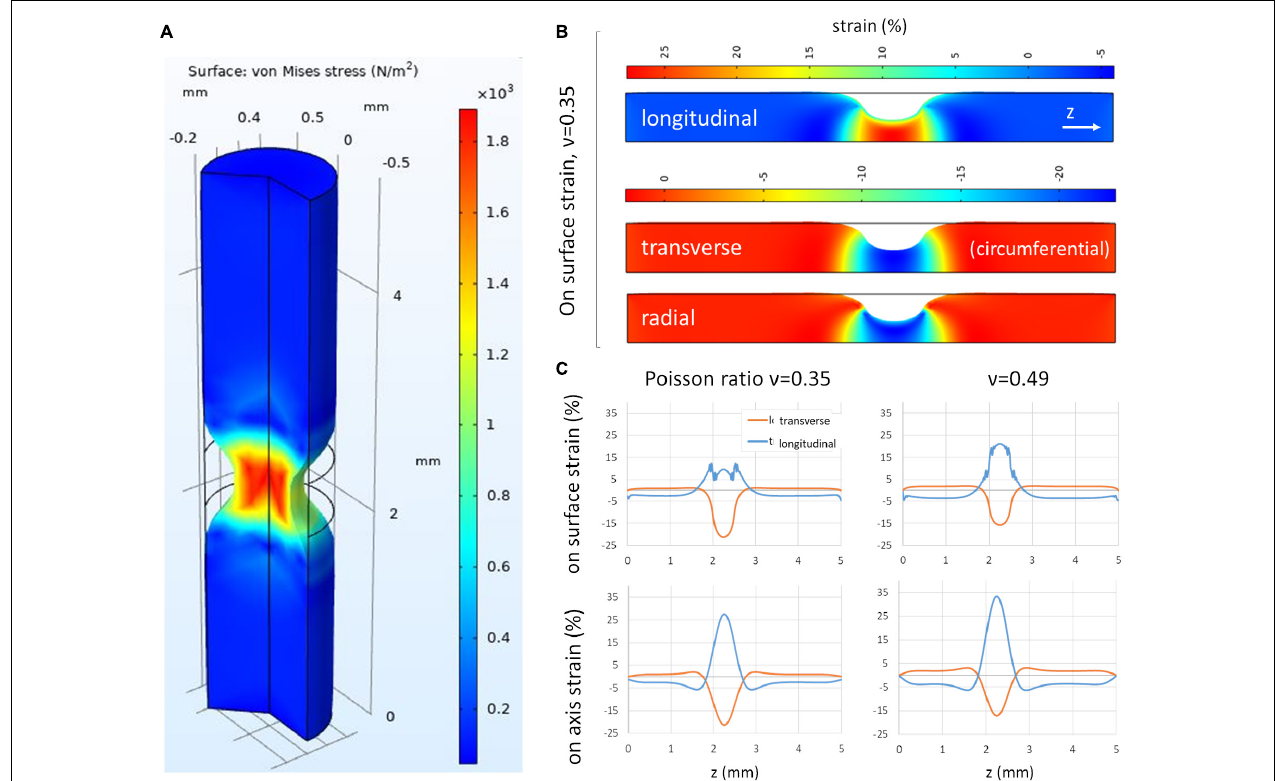
FIGURE 3 | Finite element modeling of the gut subject to a circular contraction. (A) 3D view of von Mises stress, (B) longitudinal, transverse and radial stress, 2D view (of 3D axisymmetric model), (C) Transverse and longitudinal strain on gut surface and on gut axis for two values of the Poisson ratio ν = 0.35 and ν = 0.49, as a function of longitudinal position along the gut